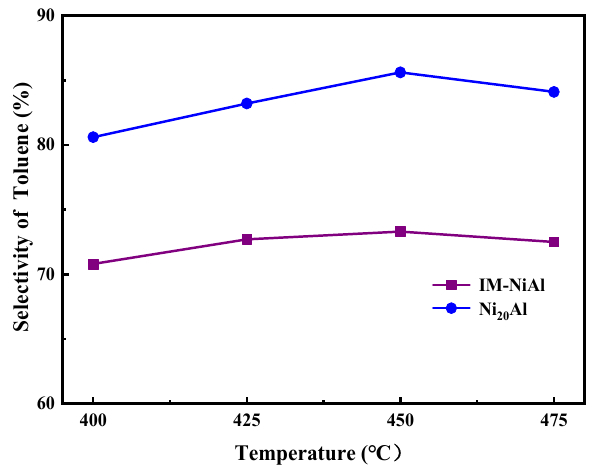
Figure 6. Toluene selectivity over the Ni 20 Al and IM-NiAl catalysts at different temperatures. The hydrogen release rates in the dehydrogenation of MCH at different temperatures over the Ni 20 Al and IM-NiAl catalysts are shown in Figure 7. It increased and then decreased with the gradual increase in temperature over both the catalysts. The hydrogen release rate over the Ni 20 Al catalyst increased from 47.01 to 63.94 mmol g − 1 h − 1 at the range of 400–450 ◦ C, but started to decrease after the temperature was further increased. The optimized hydrogen release rate over the Ni 20 Al catalyst was 61.47 mmol g − 1 h − 1 , which is superior to that of the IM-NiAl catalyst prepared by the conventional impregnation method (35.84 mmol g − 1 h − 1